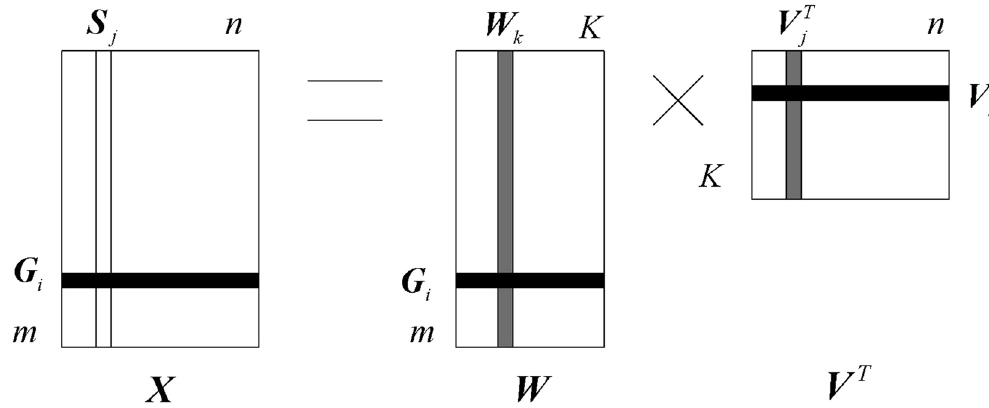
Figure 1. The graphical depiction of gene identification using